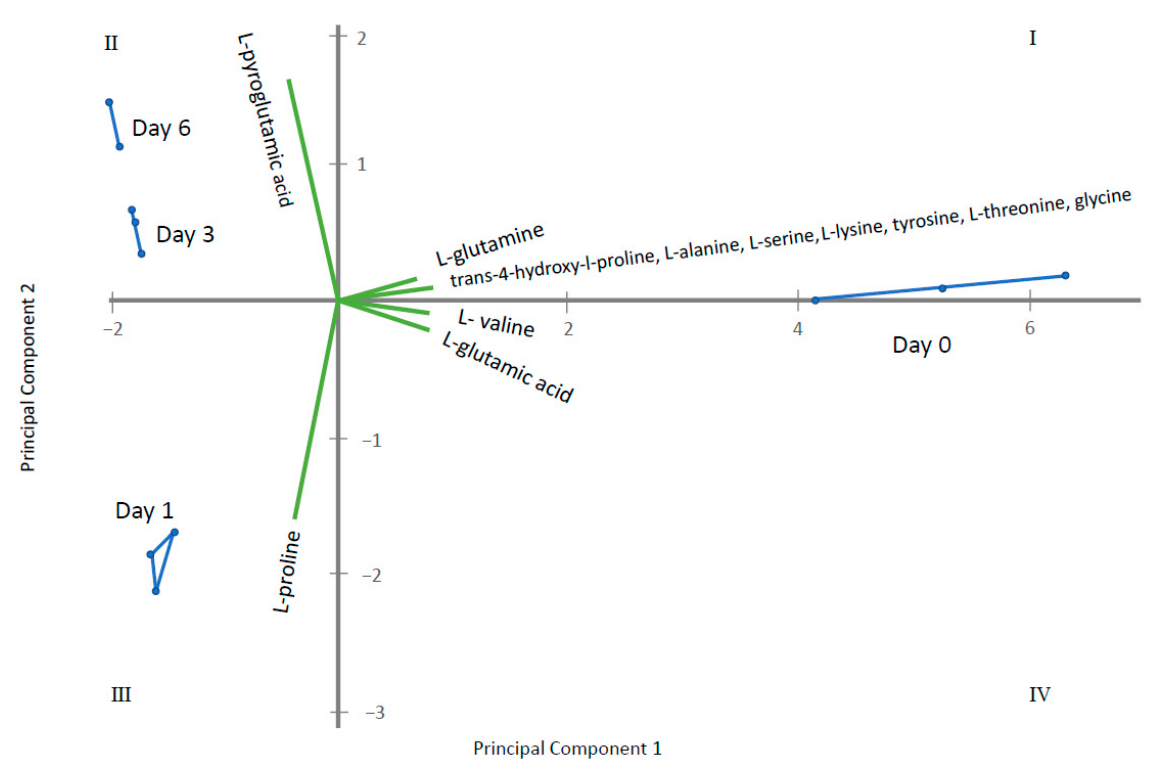
Figure 5. Principal Component Analysis (PCA) for amino acids where Principal Component 1 displays 85% of the variability and Principal Component 2—12.6%. The green vectors represent each metabolite, whose projection of the vertex on each axis represents its contribution to each PC. The blue points are each sampling time replicate, connected by lines to represent the PC scores of the samples analyzed.